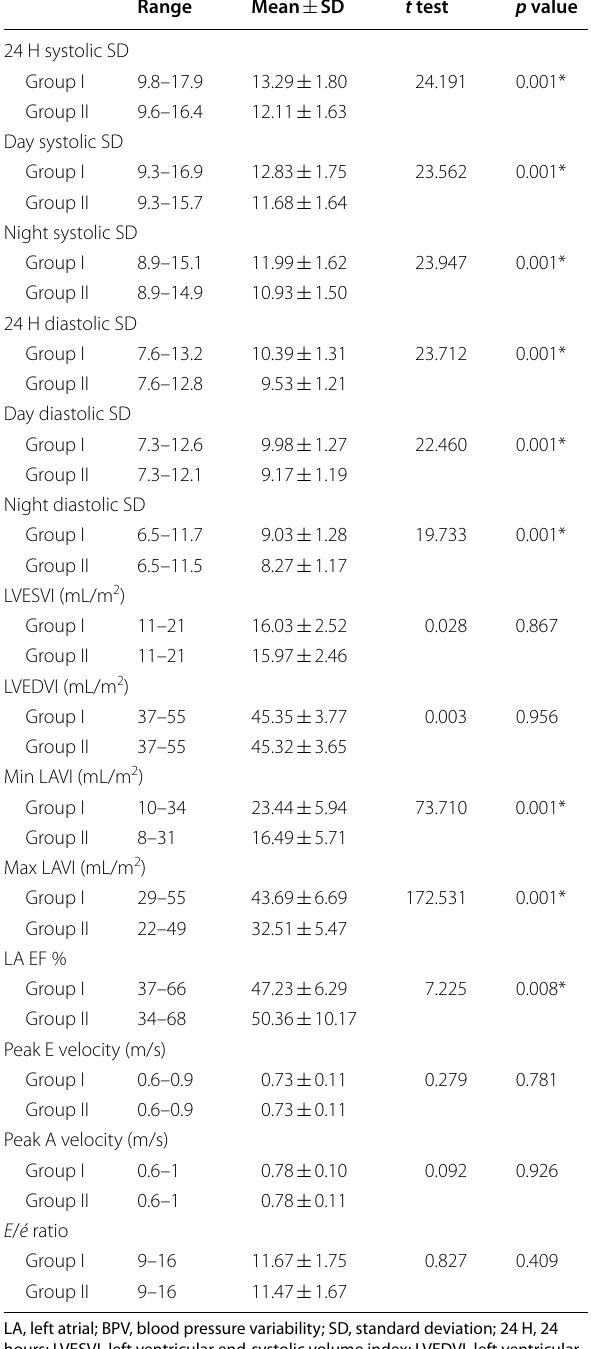
Table 2 Comparing antihypertensive medication of the study population